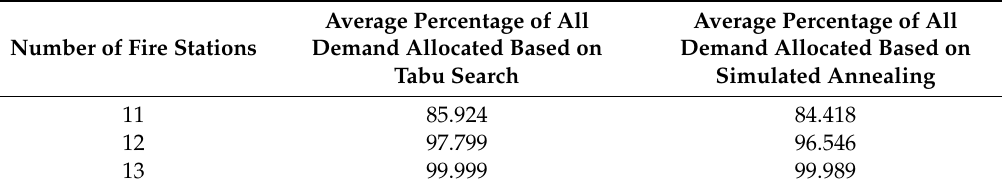
Table 6. The average percentage of demand allocated using both algorithms.